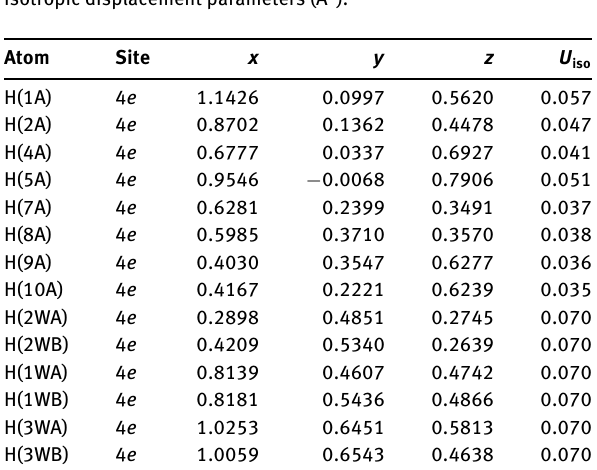
Table 2: Fractional atomic coordinates and isotropic or equivalent isotropic displacement parameters (Å 2